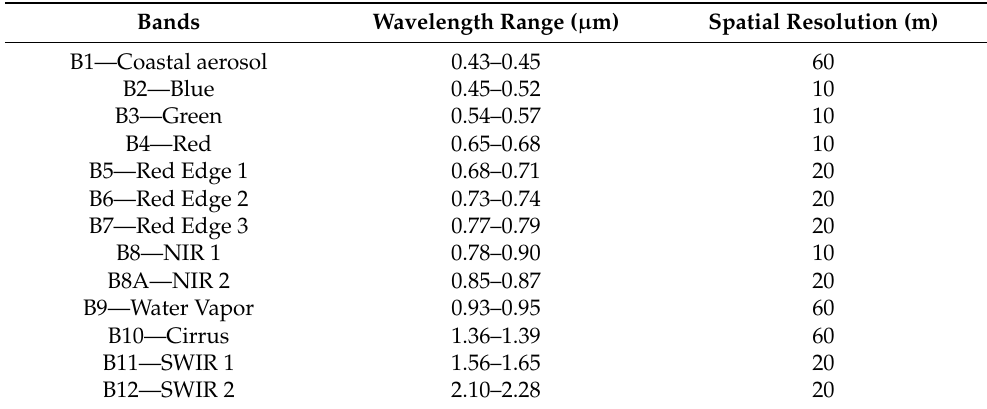
Table 2. Main characteristics of the Sentinel-2 MSI